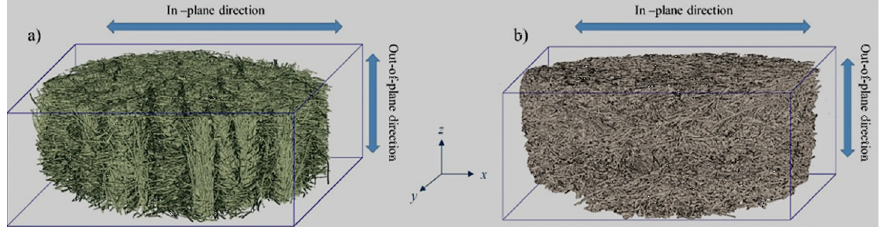
ysis: ( a ) soft felt and ( b ) rigid board samples, with indication of xy -direction (i.e., in-plane “IP” direction) and z -direction (i.e., out-of-plane “OP” direction).